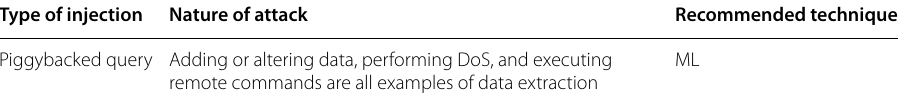
Table 3 Piggybacked query [54] Type of